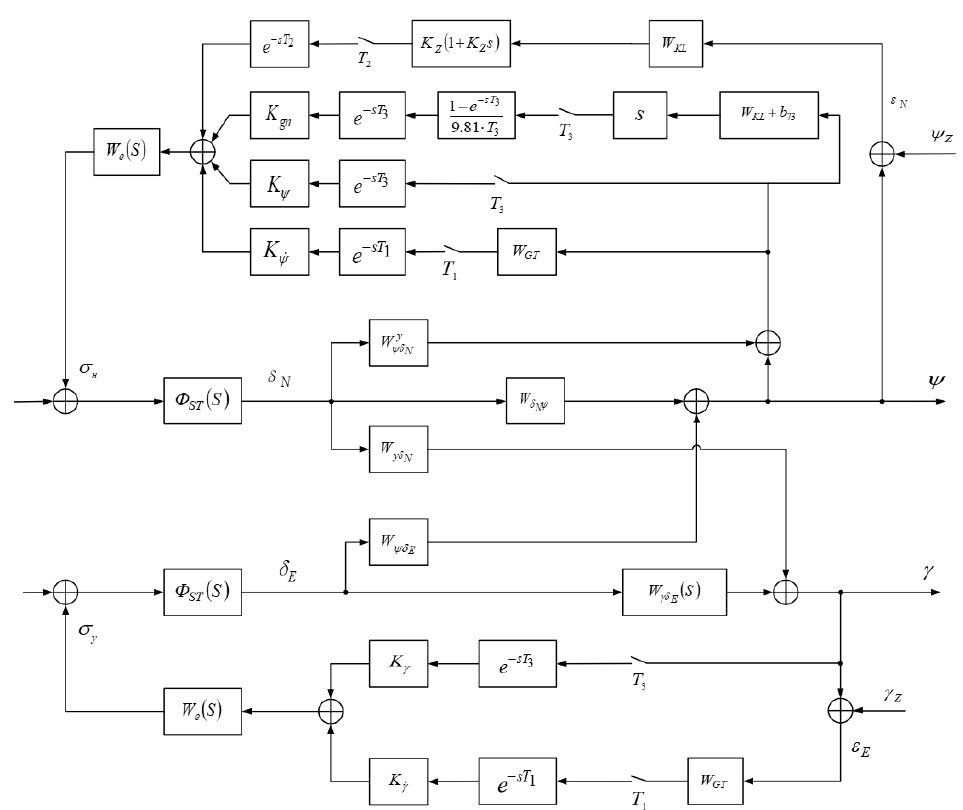
Figure 1. Block diagram of the complete model of the lateral system stabilization UAV.